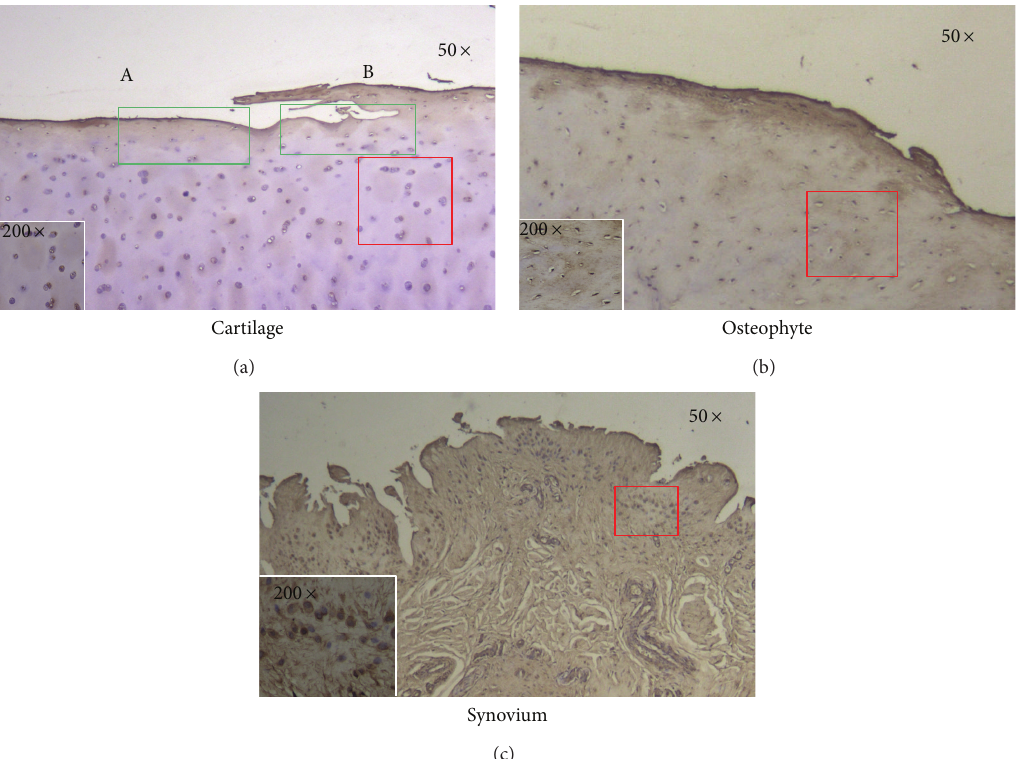
Figure 6: Immunohistochemical analysis of nesfatin-1 in OA knee cartilage, osteophytes, and synovium under 50 × and 200 × electron microscope fields. All three tissues expressed nesfatin-1, which was especially high in the lesional areas of cartilage (B > A) and the superficial layers of osteophytes and synovium. Chondrocytes, osteophyte cells, and synoviocytes were strongly stained ((a) damaged cartilage area, (b) nondamaged cartilage